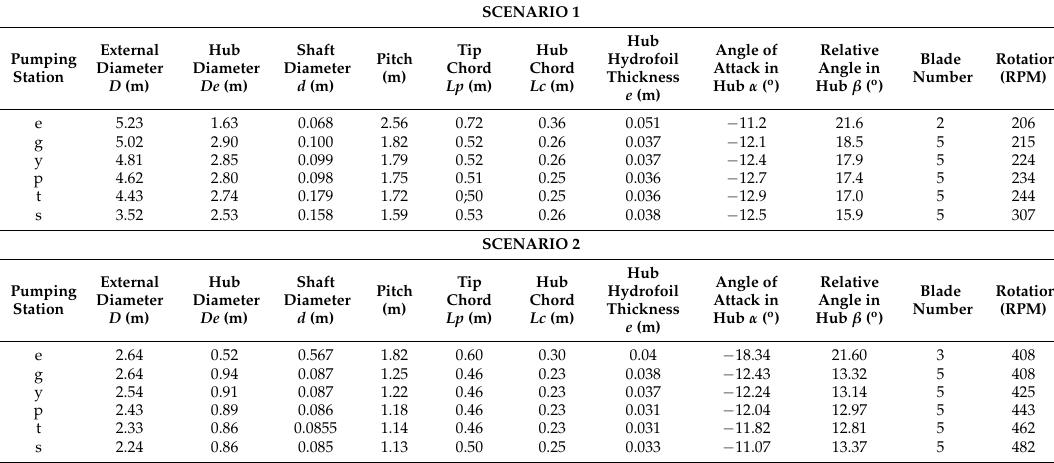
Table 8. Dimensions of the axial pumps for underwater pipeline Nile-Tel Aviv/Gaza. Scenario 1 (200 L/capita/day), Scenario 2 (81